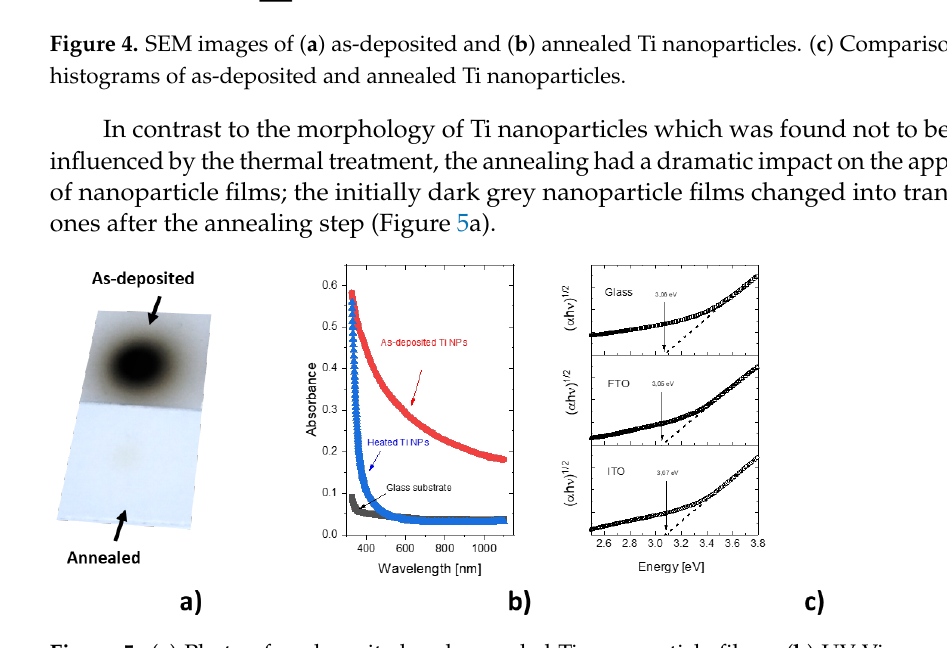
Figure 5. ( a ) Photo of as-deposited and annealed Ti nanoparticle films. ( b ) UV-Vis spectra of as- deposited and annealed Ti nanoparticle films deposited on a glass substrate. For comparison, the UV-Vis spectrum of an uncoated glass substrate is also presented. ( c ) Tauc’s plots of annealed Ti nanoparticle films deposited onto glass (top), FTO-coated glass (middle), and ITO-coated glass (bottom). The deposition time was 3 min, the annealing temperature was 450 °C, and the annealing time was 120 min.